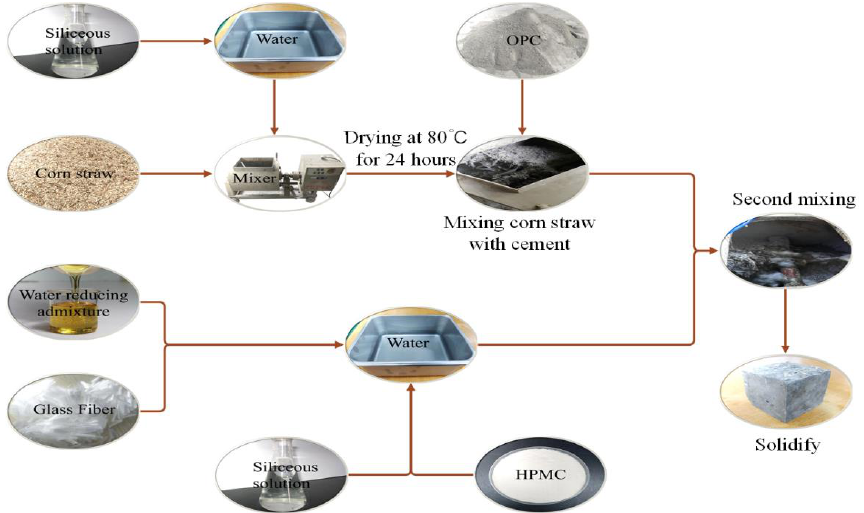
Figure 3. CSCC production flow chart.